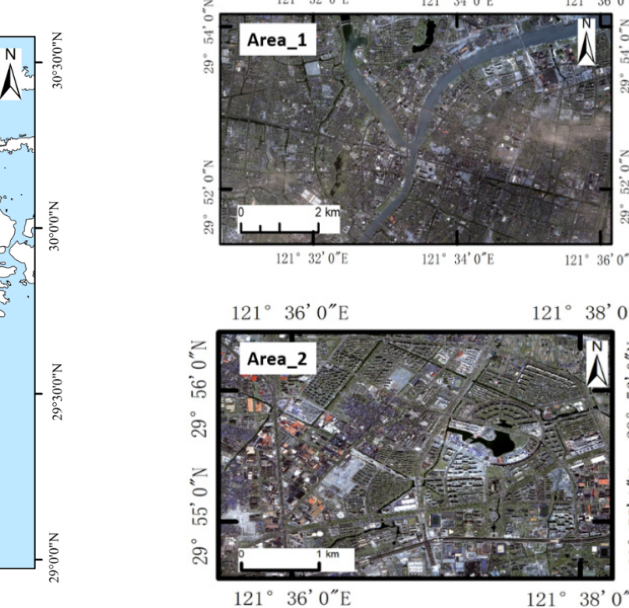
Figure 1. The two study areas utilized in this